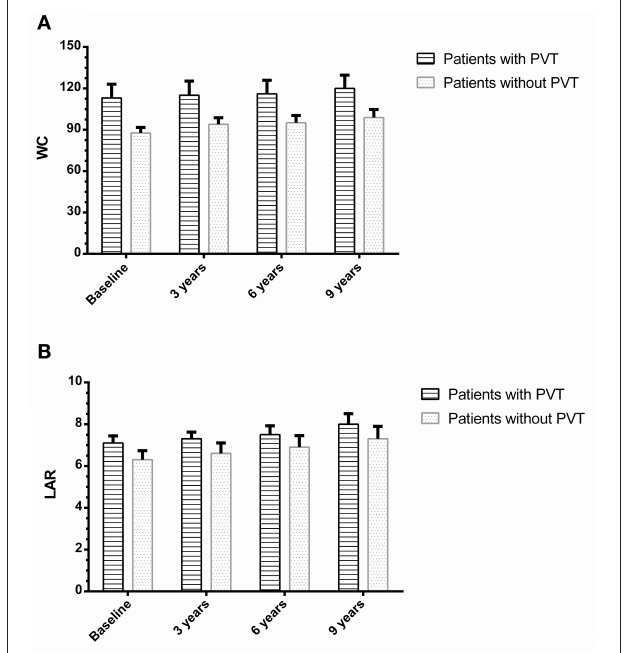
FIGURE 3 | The receiver operating characteristic curves of waist circumference and leptin/adiponectin ratio in predicting portal vein thrombosis in non-cirrhotic NAFLD.